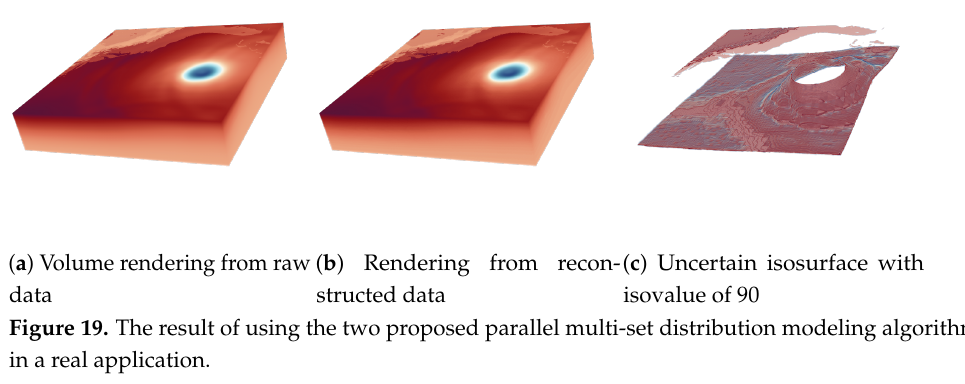
Figure 19. The result of using the two proposed parallel multi-set distribution modeling algorithms in a real